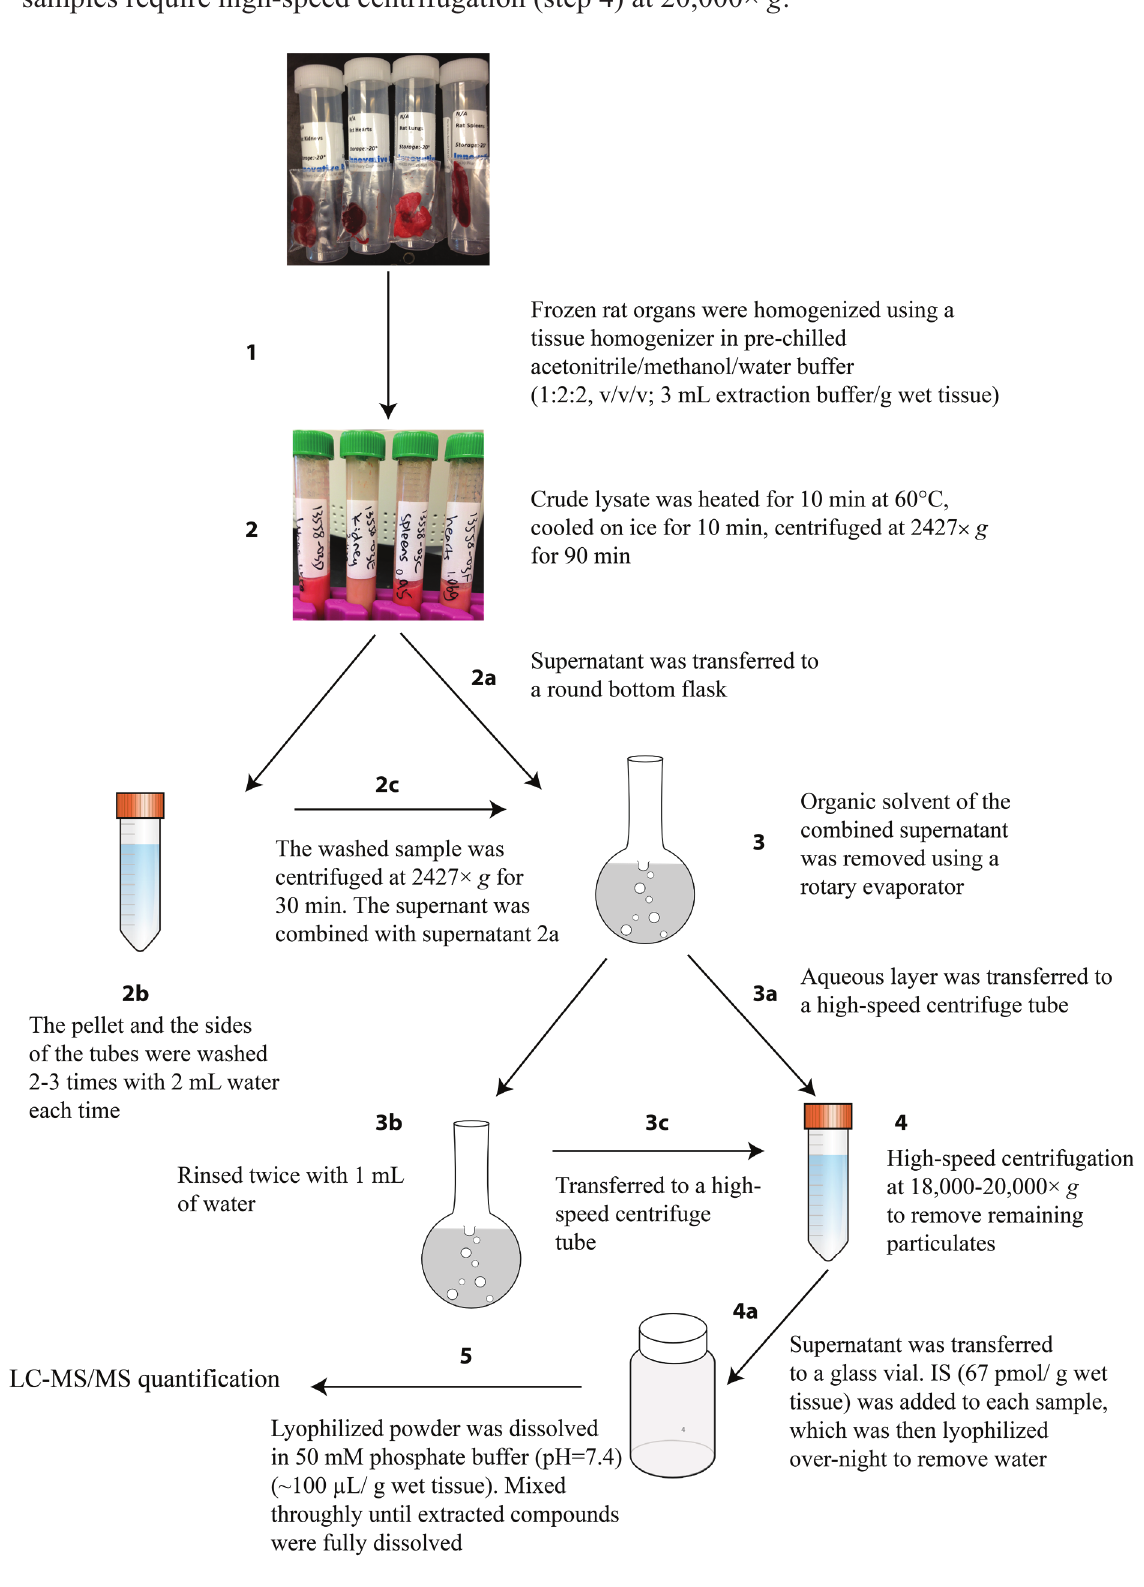
Figure 2. Workflow chart of cNMPs extraction from rat organs. Brain, spleen and heart samples require high-speed centrifugation (step 4) at 18,000× g . Liver, lung and kidney samples require high-speed centrifugation (step 4) at 20,000× g